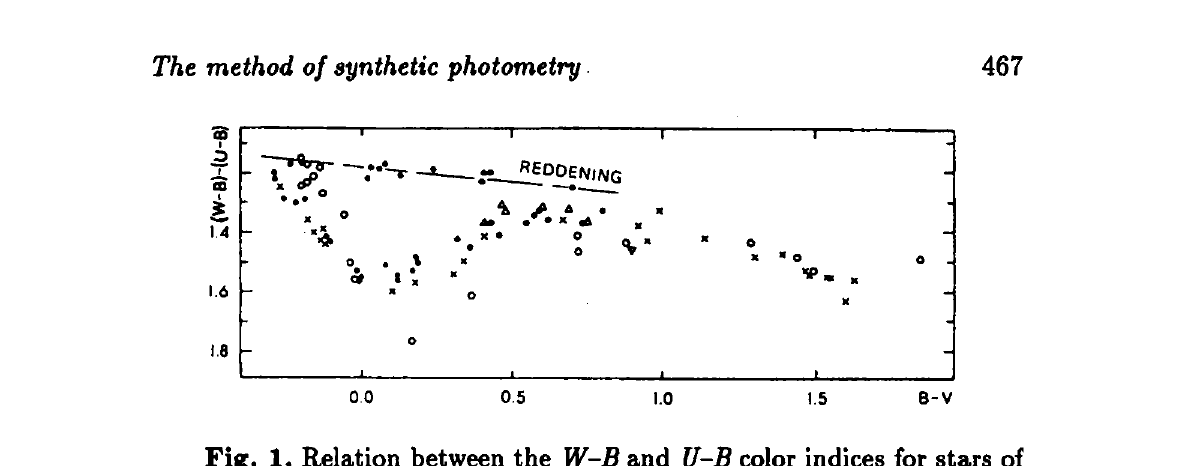
Fig. 1. Relation between the W-B and U-B color indices for stars of different luminosities. Dots represent main sequence stars, triangles repre- sent subgiants, crosses represent giants and circles represent supergiants.